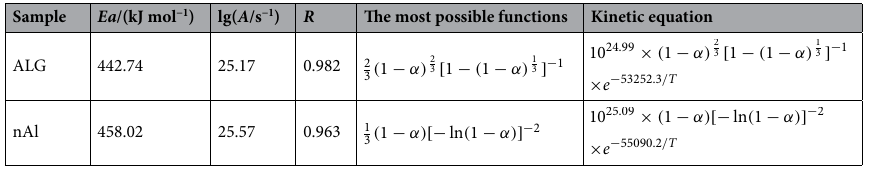
Table 1. Kinetic parameters of exothermic reactions of the ALG and the nAl.